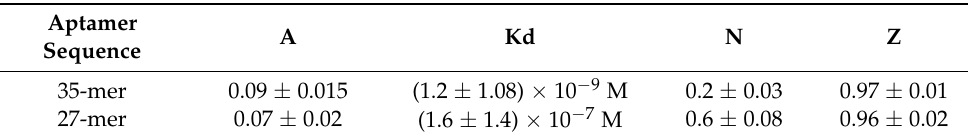
Table 2. Summary of the best-fit parameters from the Langmuir-Hill isotherm for the 35-mer and 27-mer adenosine